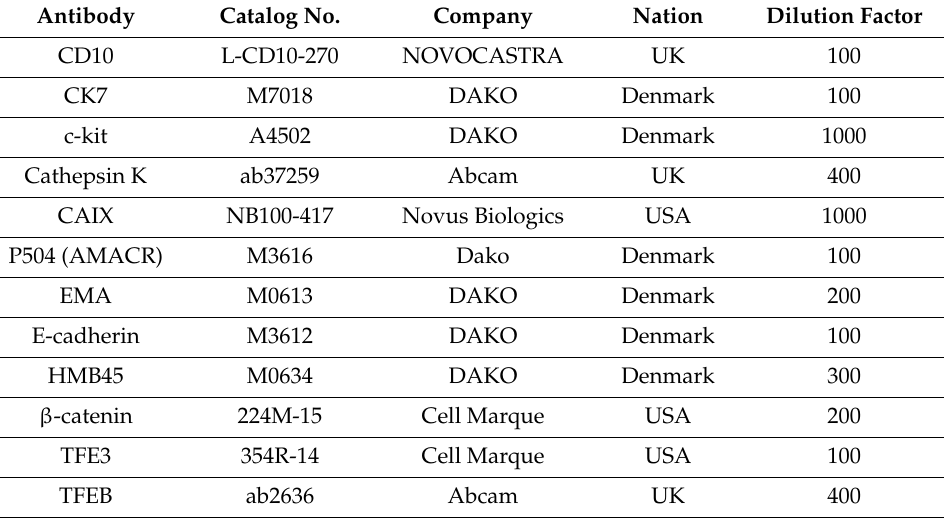
Table 4. Information on primary antibodies used for immunohistochemical analysis.